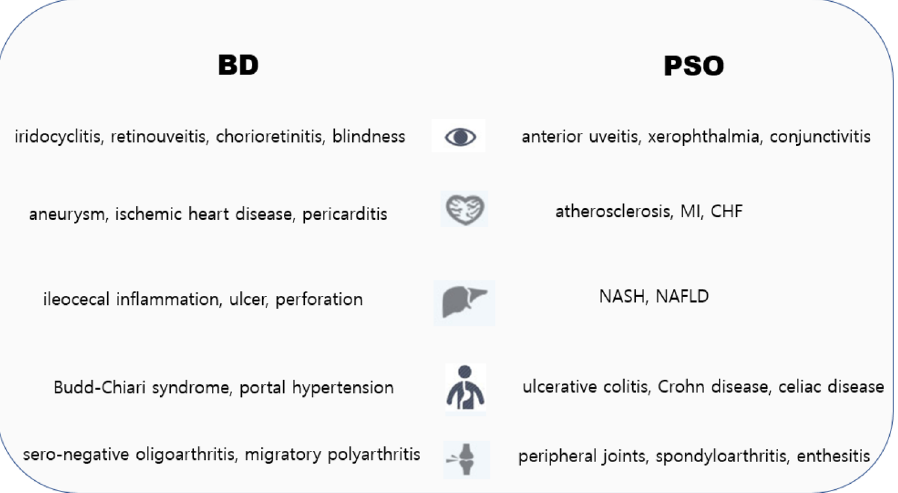
Figure 1. Extracutaneous manifestations of BD and PSO. PSO, psoriasis; BD, Behçet disease; MI, myocardial infarction; CHF, congestive heart failure; NASH, non-alcoholic steatohepatitis; NAFLD, non-alcoholic fatty liver